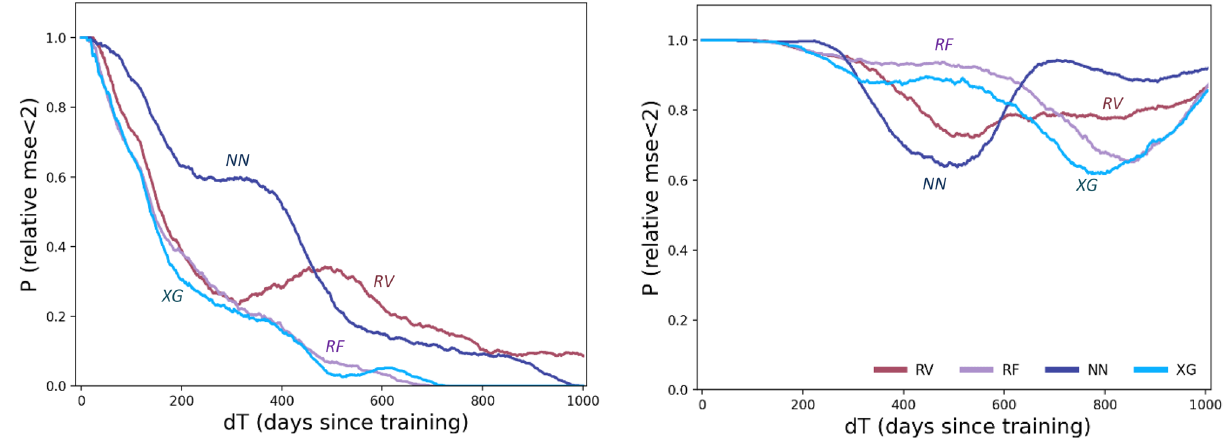
Figure 8. Probability P ac (dT) of different models performing accurately as a function of time (maintaining E rel < 2.0), on two sample datasets. Note the variability in degradation patterns between different models, and different